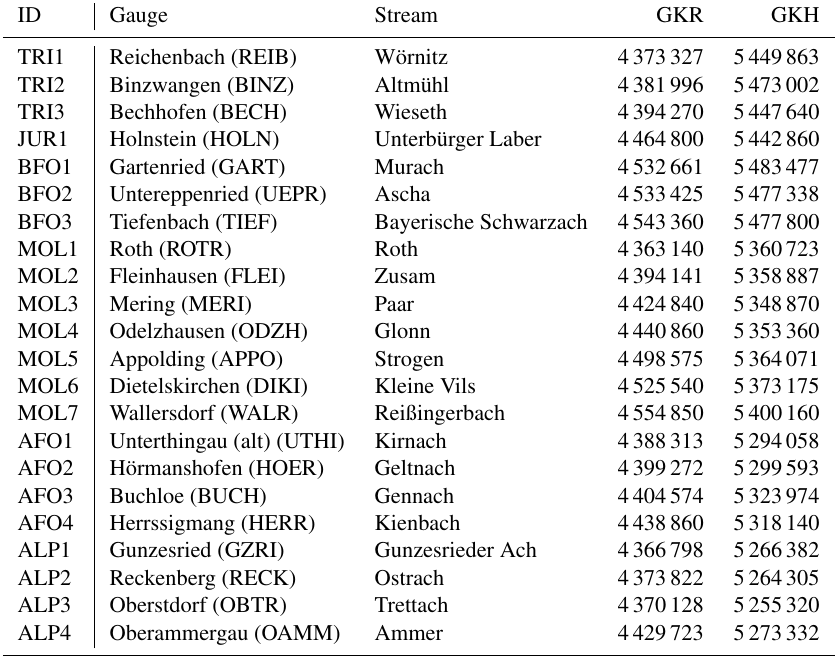
Table C1. Link table that relates the site identifiers (ID) introduced in Sect. 2.1 to the corresponding gauge and stream names. Gauge locations are provided in Gauß–Krüger zone 4 coordinates (GKR and GKH, CRS identifier